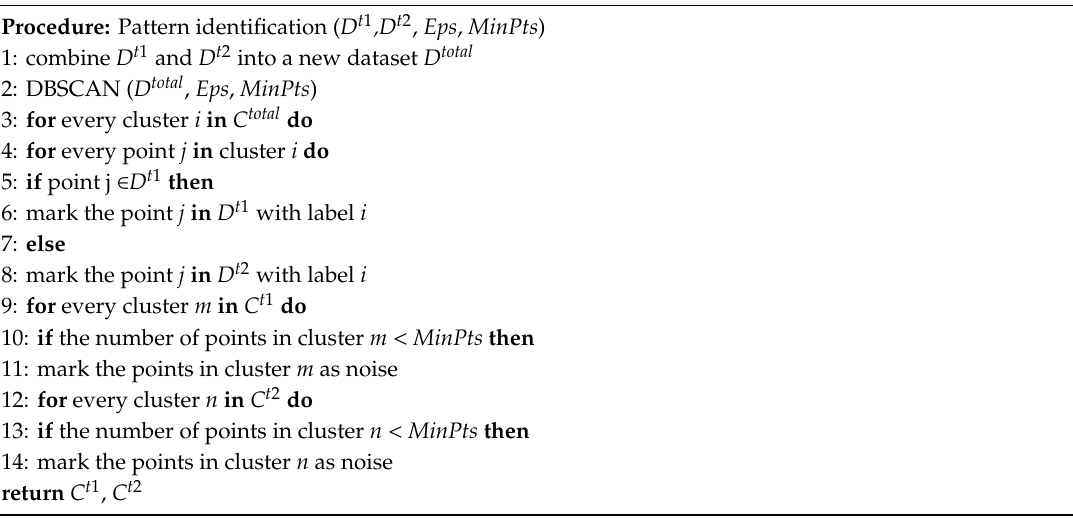
Algorithm 1 Pattern identification algorithm.